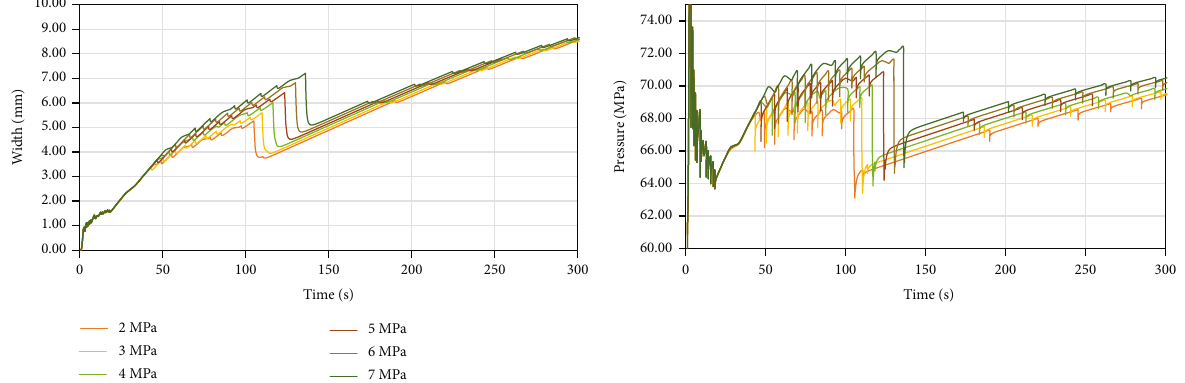
Figure 16: The in fl uence of stress di ff erence between the mud interlayer and sand on injection pressure and fracture width.